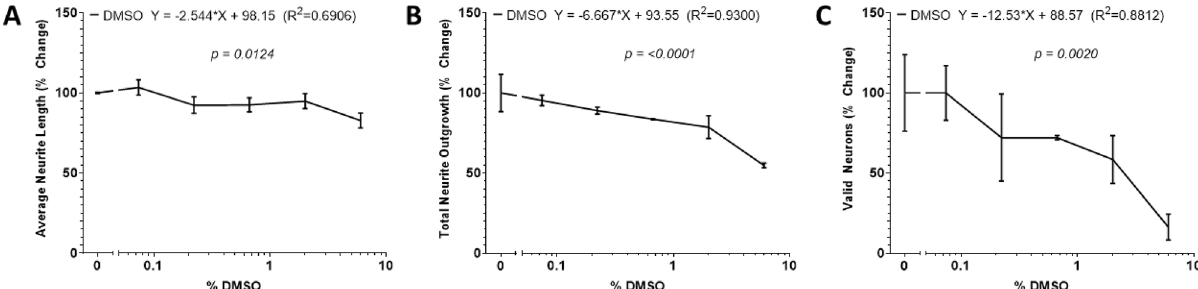
Figure 5. The effects of the drug vehicle DMSO. Linear trends of the ( A ) average neurite length, ( B ) total neurite outgrowth, and ( C ) number of valid neurons of primary cortical neurons isolated from young adult male mice cultured in various percentages of DMSO for 2DIV. The X-axis denotes the percentage of the neuron media comprising of DMSO. The values are expressed as percent change relative to the 0% DMSO cohort. Simple liner regression conducted to determine P value, goodness of fit, and if the slope differs significantly from 0.2 wells per condition (n = 2). Graphs show mean and SEM.